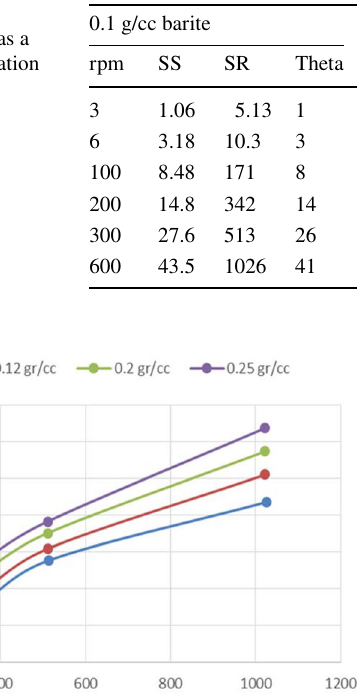
Table 3 The rheological properties of drilling fluid as a function of barite concentration